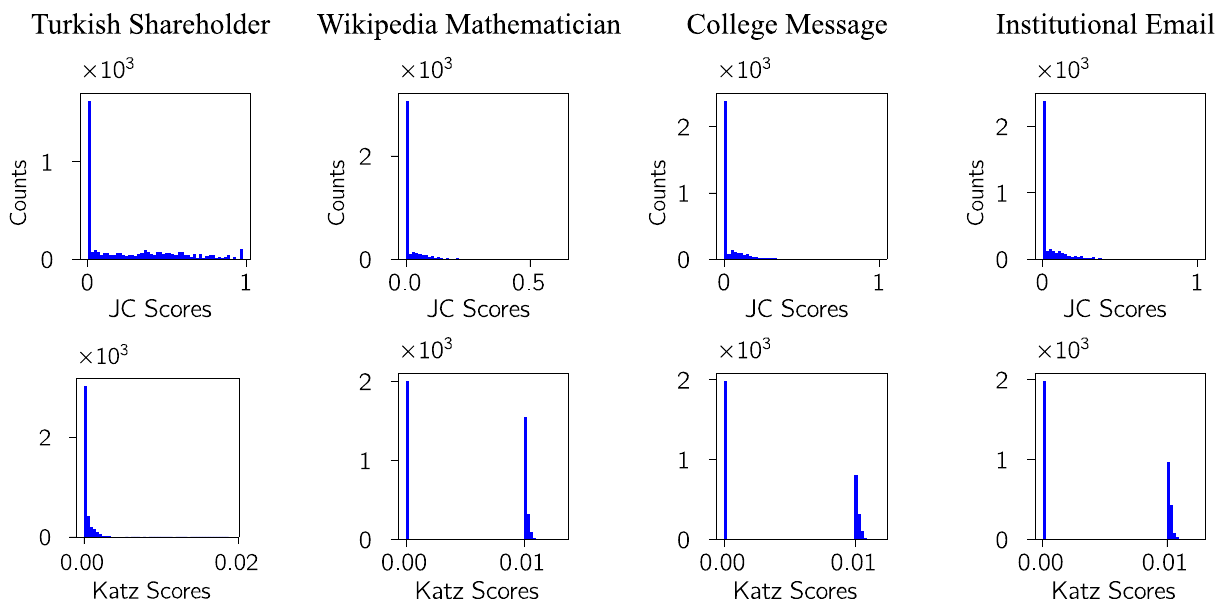
Figure 6. The histogram of node similarity scores using Jaccard Coefficient (JC) & Katz methods on four real data sets. Each column is for one data set which are, from left to right: Turkish Shareholder networks, WikiWikipedia Mathematician networks, College Messages network, and Email networks. The first row is the similarity score used in Jaccard Coefficient method and the second is for the Katz method. The precise values are not important here as the key feature is the success or failure to identify two clear groups of low- and high- scoring node pairs. We under-sampled 1000 linked node pairs and 1000 non-connected node pairs 67 . Only the Katz method (bottom row) shows the necessary clustering of scores needed for link prediction. Similar plots for all the link prediction methods used in this paper are shown in Figure E11 of the Appendix.